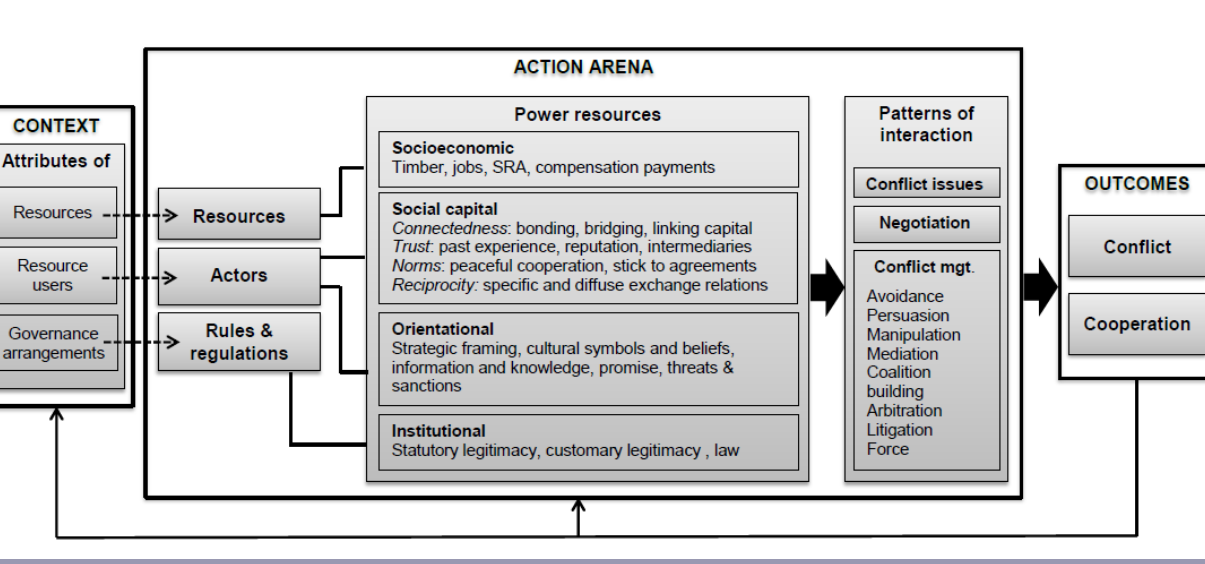
Fig. 1. Analytical framework for the study. The framework draws from Ratner et al. (2013) for context, action arena (with resources, actors, rules and regulations, and patterns of interaction), and outcomes; from Marfo (2006) for power resources; and from Lyon (2000), Pretty and Ward (2001), Pretty (2003) for components of social capital. Further operationalization of socioeconomic and social capital power resources resulted from a hybrid combination of deductive and inductive coding. Norms are separated from rules, which are analyzed as a separate part of the action arena, following Ratner et al. (2013).